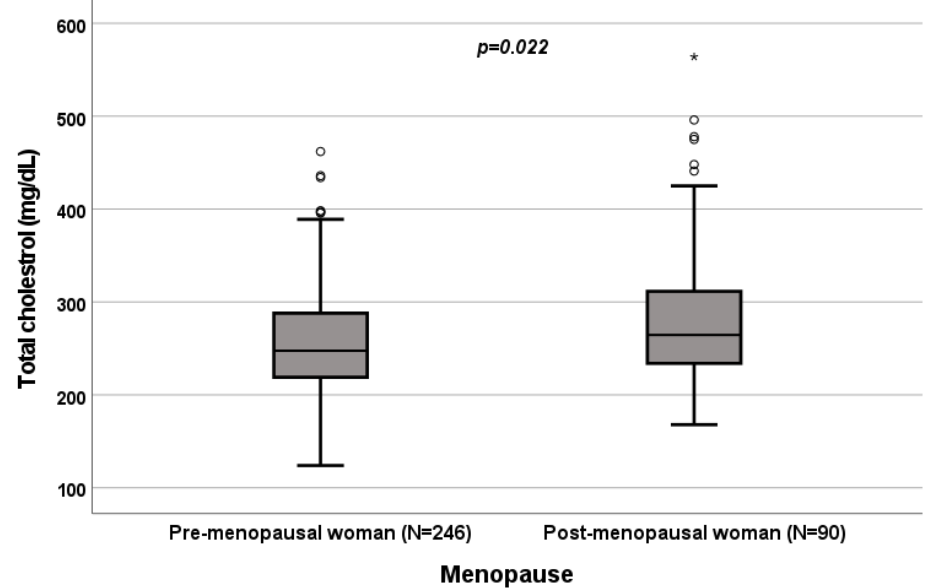
Figure 4. Influence of menopause on total-cholesterol levels (mg/dL). Box plot of sex’s influence on total-cholesterol levels (mg/dL): The black lines in the boxes show the interquartile ranges (IQRs): quartile 1, median values and quartile 3; the open dots and stars describe the outlier values. The p -value is shown.